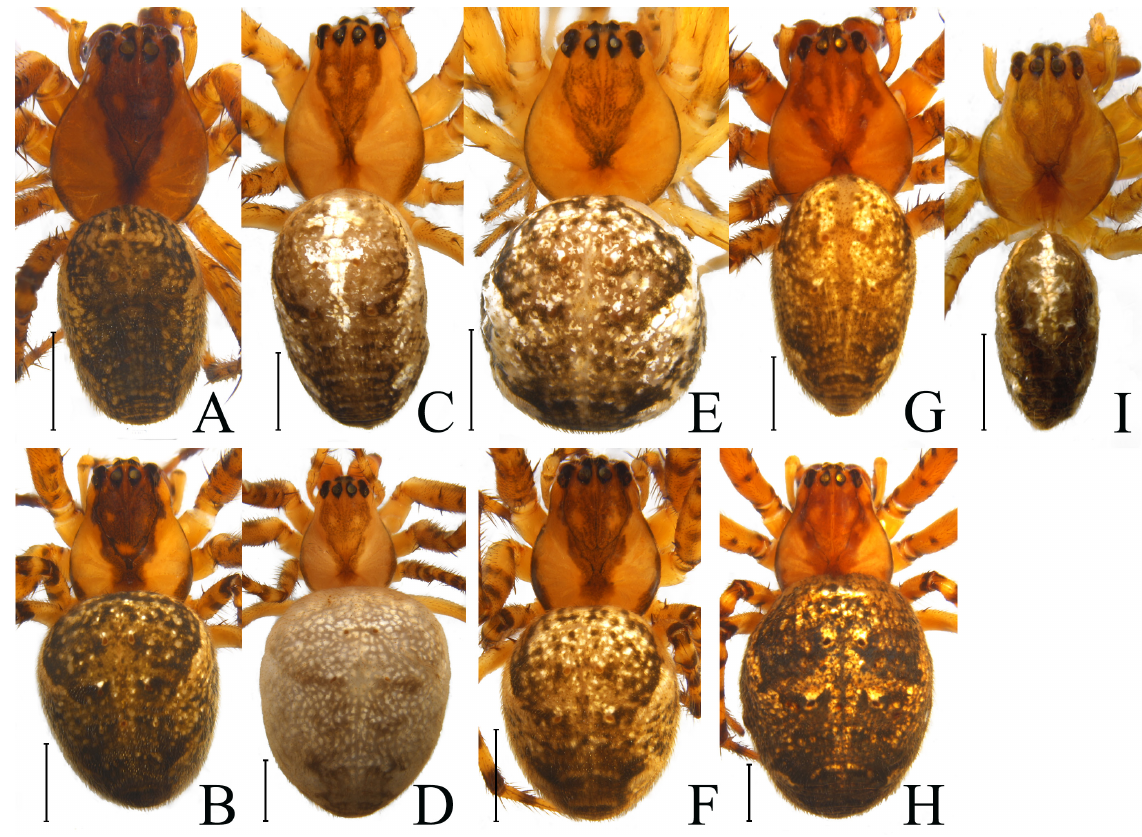
Fig. 1. Meta hamata sp. nov. (A–B), Meta longlingensis sp. nov. (I), Meta tangi sp. nov. (C–D) , Meta yani sp. nov. (E–F), Meta yinae sp. nov. (G–H). A , C , E , G , I . Male holotype habitus, dorsal view. B , D , F , H . Female paratype habitus, dorsal view. Scale bars: 1